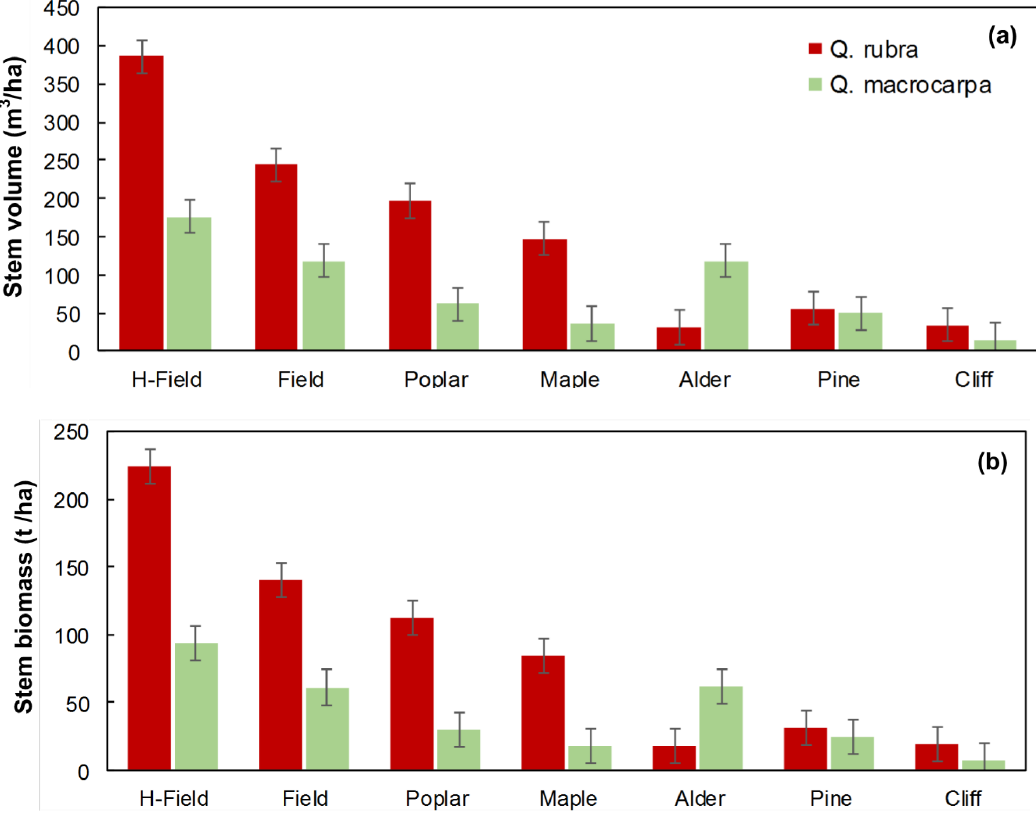
Figure S1. Allometric relationships between DBH, and ( a ) stem volume or ( b ) stem biomass in 18 year-old bur oak ( Q . macrocarpa ) and red oak ( Q . rubra ) restoration plantations. All relationships and equation parameters are significant at p <